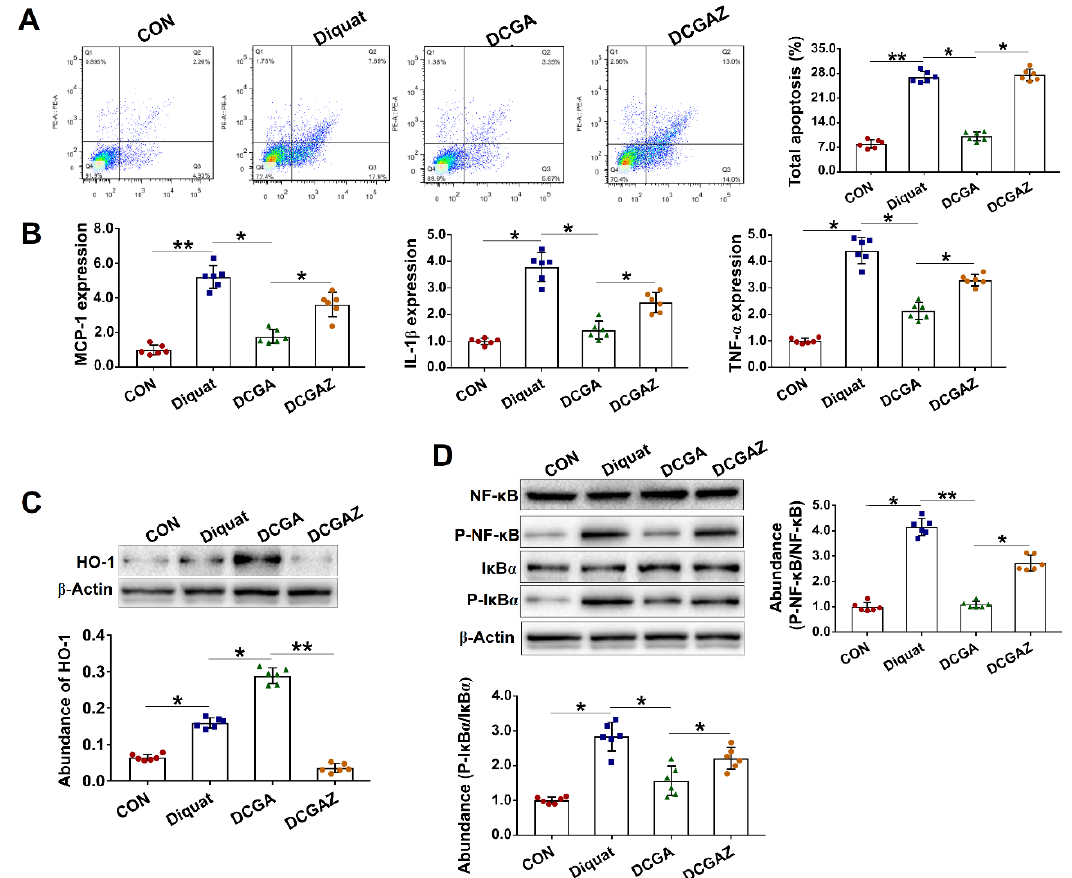
Figure 4. Chlorogenic acid (CGA)-regulated heme oxygenase-1 (HO-1) expression suppresses NF-kappa-B inhibitor alpha ( IκBα )/nuclear factor- κB ( NF- κB ) signaling in IEPC-J2 cell exposure to oxidative stress. ( A ) Analysis of cell apoptosis by flow cytometric assays. In each diagram, Q1 represents the percentage of nonviable and necrotic cells, Q2 represents the percentage of late apoptotic cells, Q3 represents the percentages of early apoptotic cells, and Q4 represents the percentage of live cells. IPEC-J2 cells were plated in 24-well plates at a density of 1 × 10 5 cells/well ( n = 6). ( B ) qPCR analysis of the expression levels of critical inflammation-related molecules. ( C ) Western-blot analysis of the abundance of heme oxygenase-1 (HO-1). ( D ) Western- blot analysis of critical signaling proteins involved in the IκBα/NF - κB pathway. CON, cells without being treated; diquat, cells were treated by 100 µM diquat; DCGA, cells were pretreated by 100 µM CGA for 6 h and were then treated by 100 µM diquat for 3 h; DCGAZ, cells were pretreated by 10 µM Zn-protoporphyrin-IX (ZnPPIX, the specific inhibitor of HO-1) and were then treated by 100 µM CGA and 100 µM diquat. * p < 0.05, ** p < 0.01.